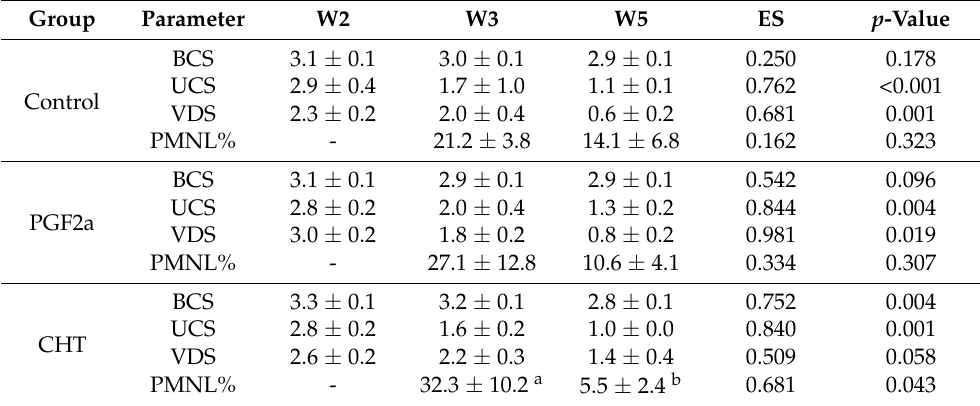
Table 1. Changes in the BCS, UCS, VDS, and PMNL% at W2, W3, and W5. Group